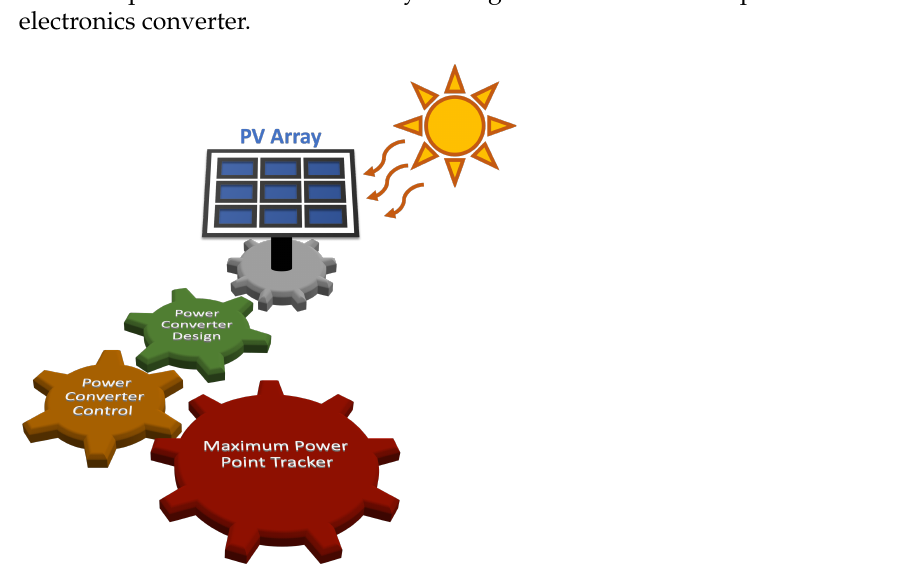
Figure 1. General elements required for a photovoltaic power